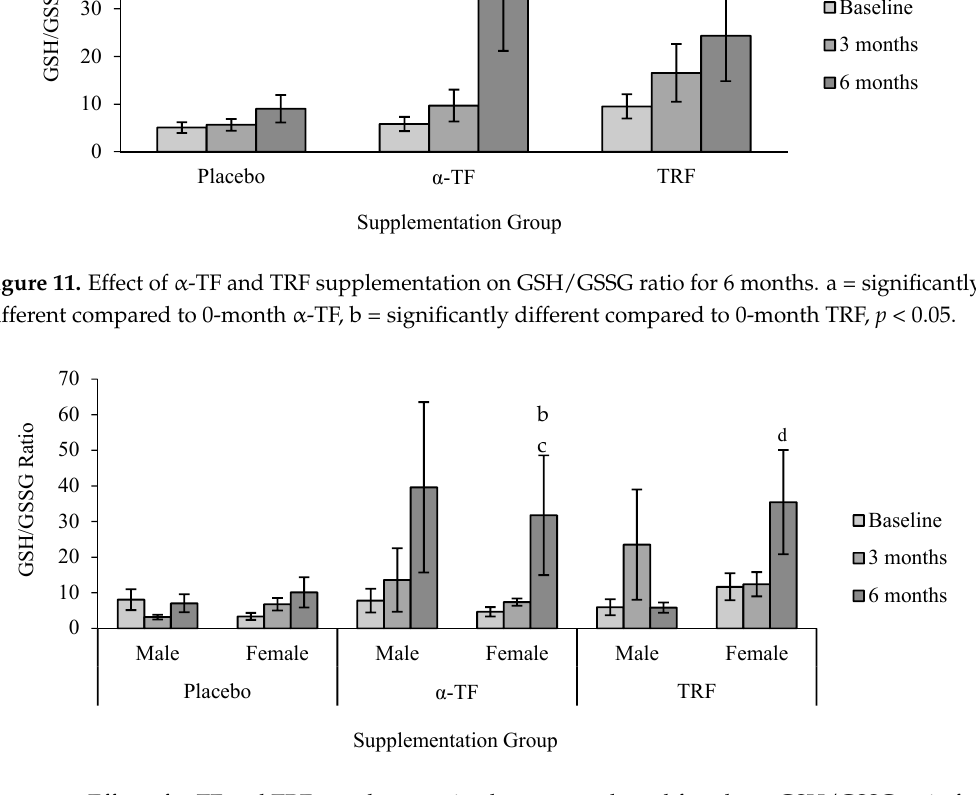
6 months. b = significantly different compared to 0-month α -TF (female), c = significantly different compared to 3-month α -TF (female), d = significantly different compared to 0-month TRF (female), p < 0.05.